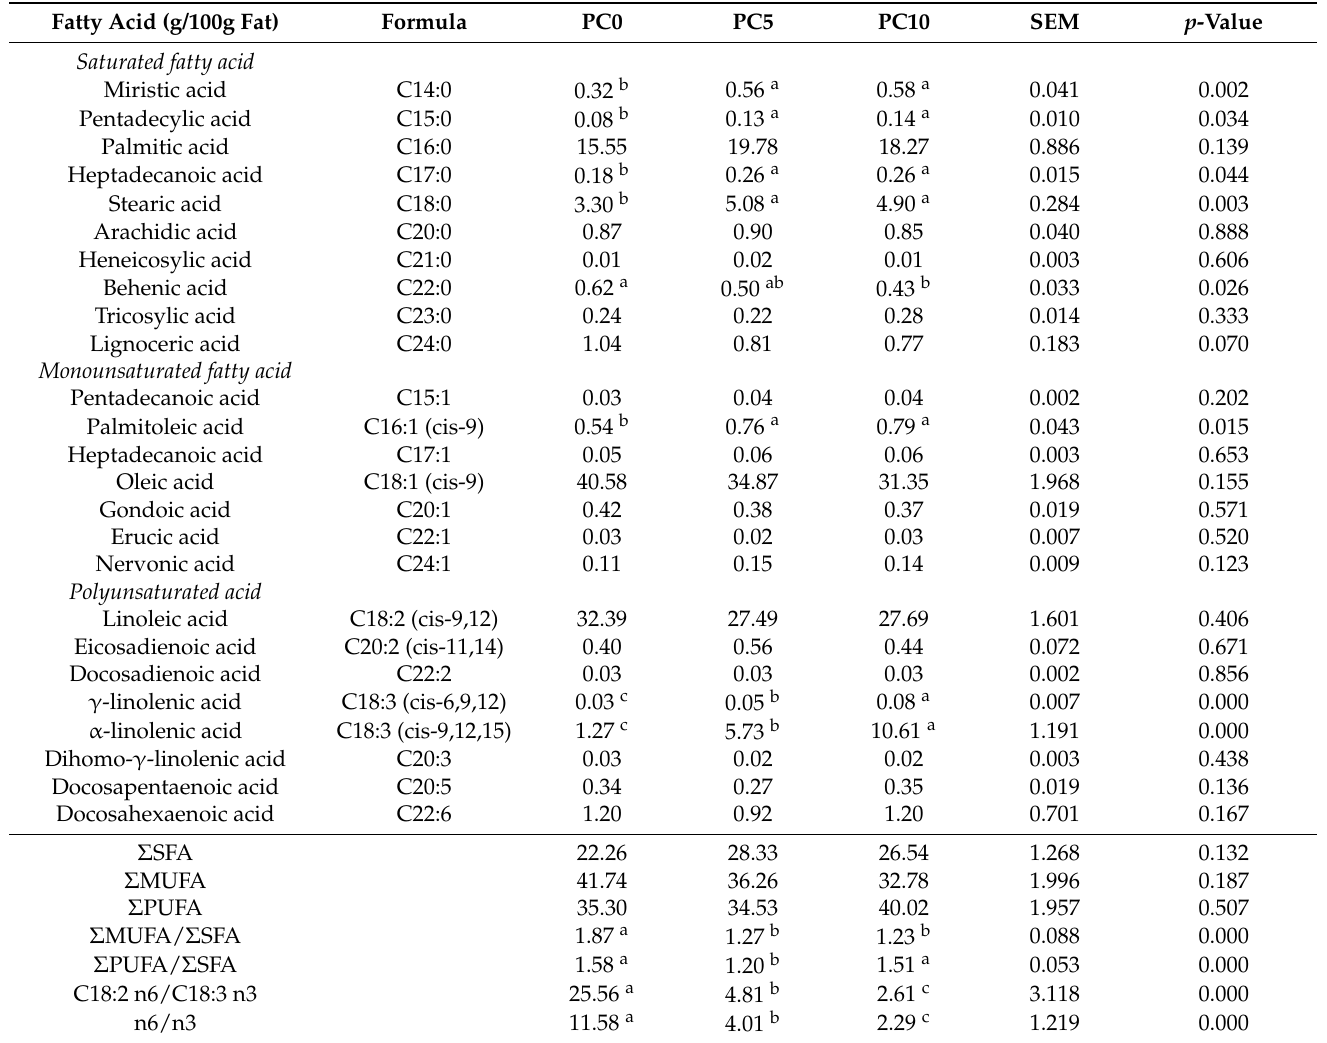
Table 2. Fatty acids composition of the experimental